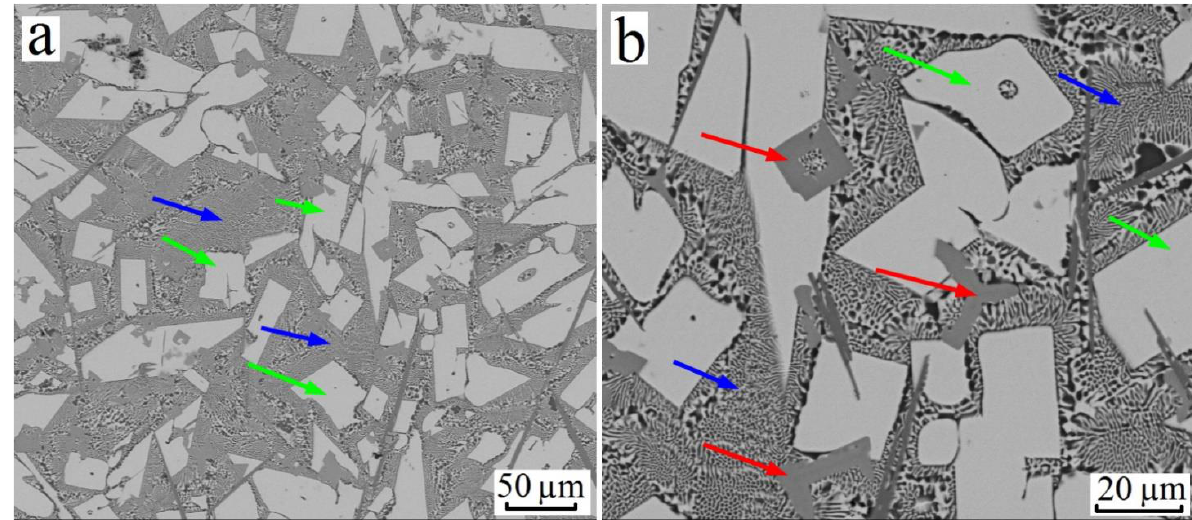
Figure 1. Distribution of structural components in the Al – 40.33Cu – 2.75Ti (T2) alloy: ( a ) magnification × 500; ( b ) magnification × 1500. The arrows point to main structural components of the alloy: the θ -phase Al 2 Cu (green arrows), the α -Al + θ eutectic (blue arrows) and L 1 2 trialuminides (red arrows).